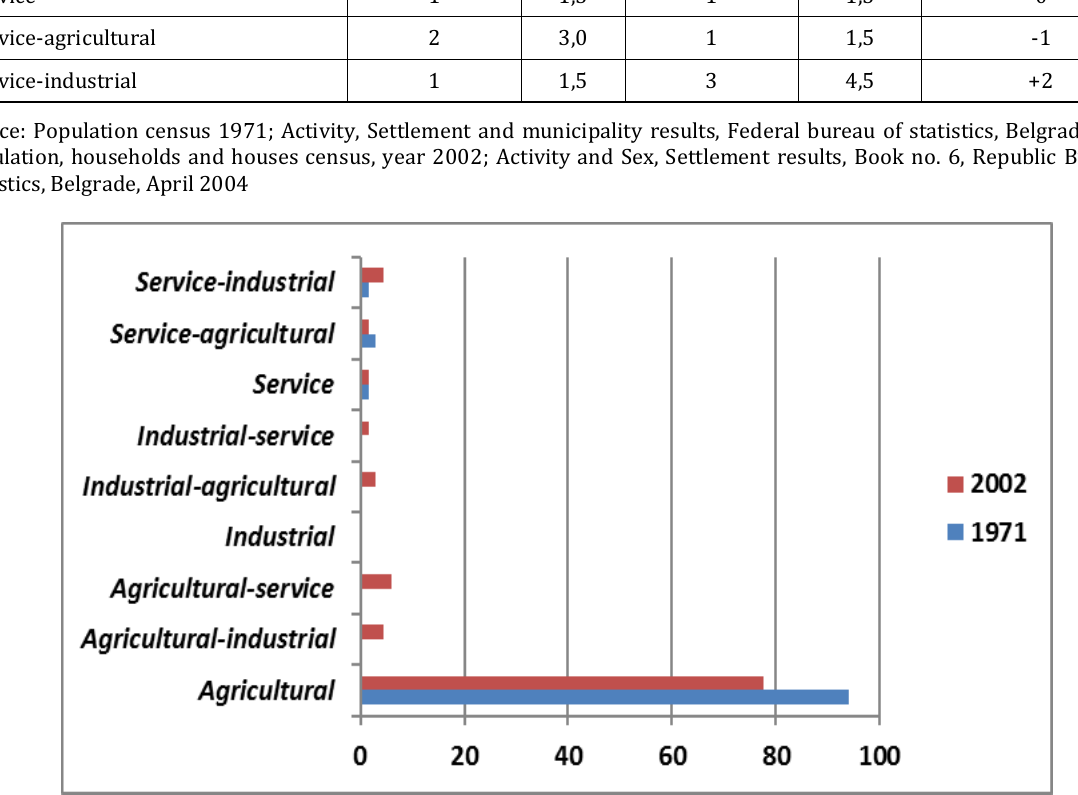
Fig. 1. Changes of functional types of Albanian settlements between